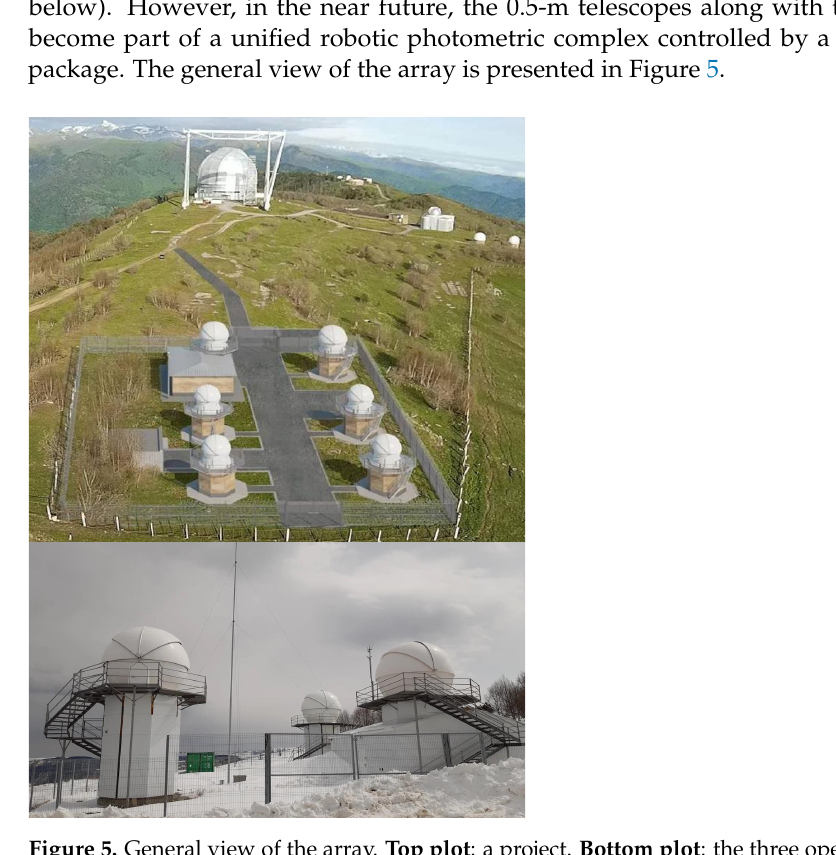
Figure 5. General view of the array. Top plot : a project. Bottom plot : the three operating